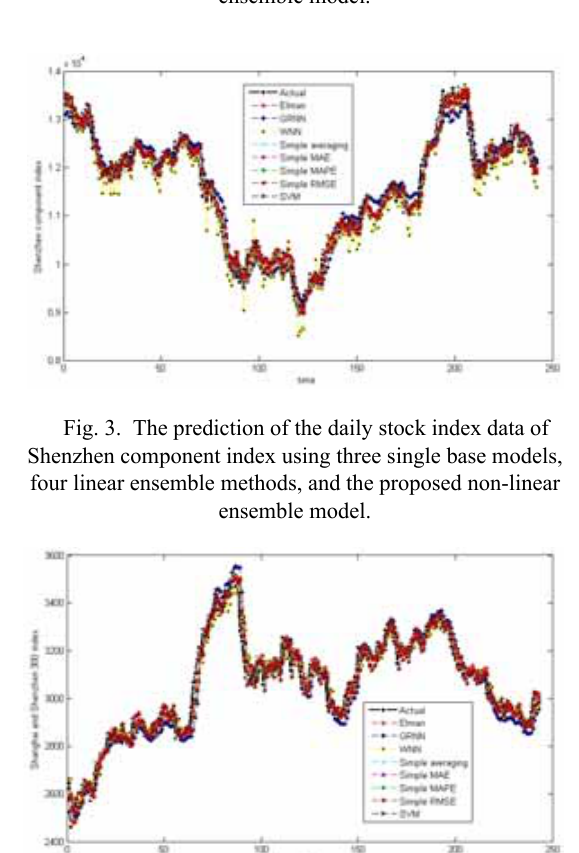
Fig. 2. The prediction of the daily stock index data of Shanghai composite index using three single base models, four linear ensemble methods, and the proposed non-linear ensemble model.